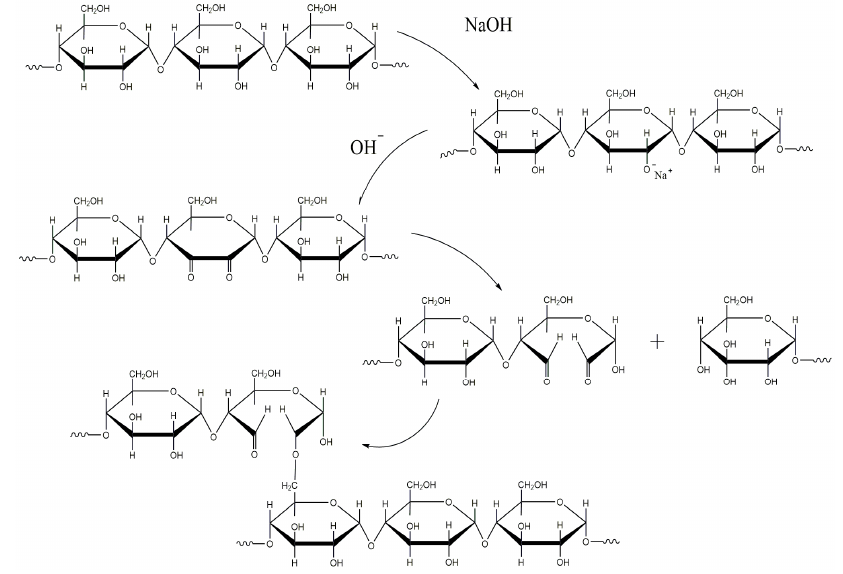
Figure 7. Hypothesis of chemical reaction of alkali treated HAS during extrusion.